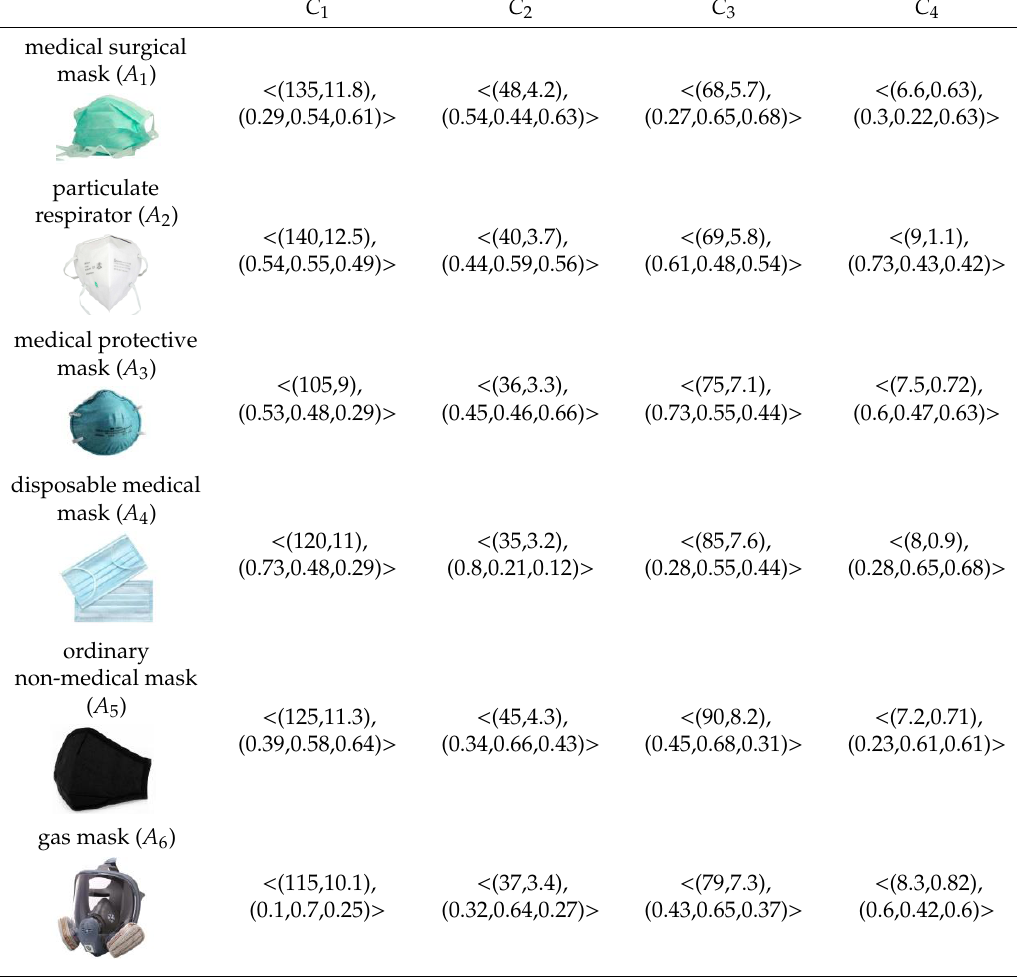
Table 1. Original decision information matrix